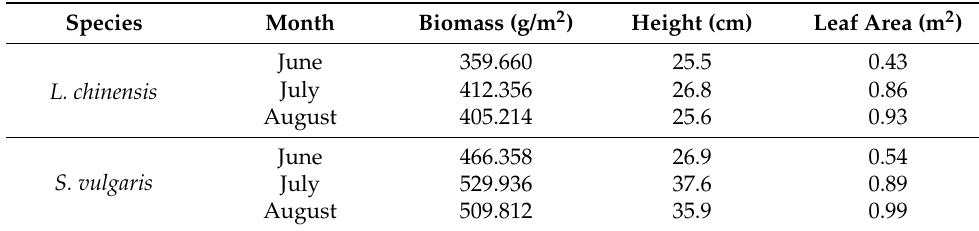
Table 4. Plant indicators.